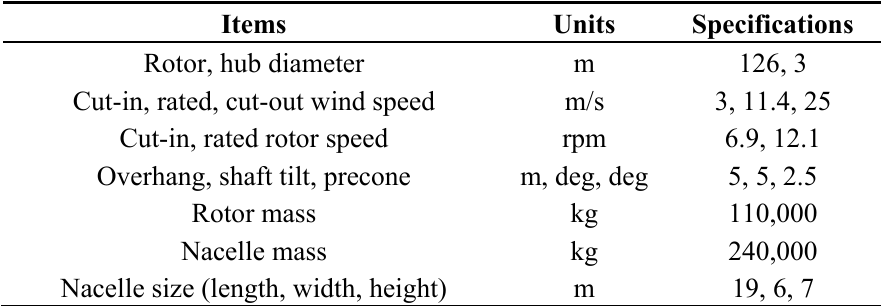
Table 2. Properties of the NREL offshore 5-MW baseline wind